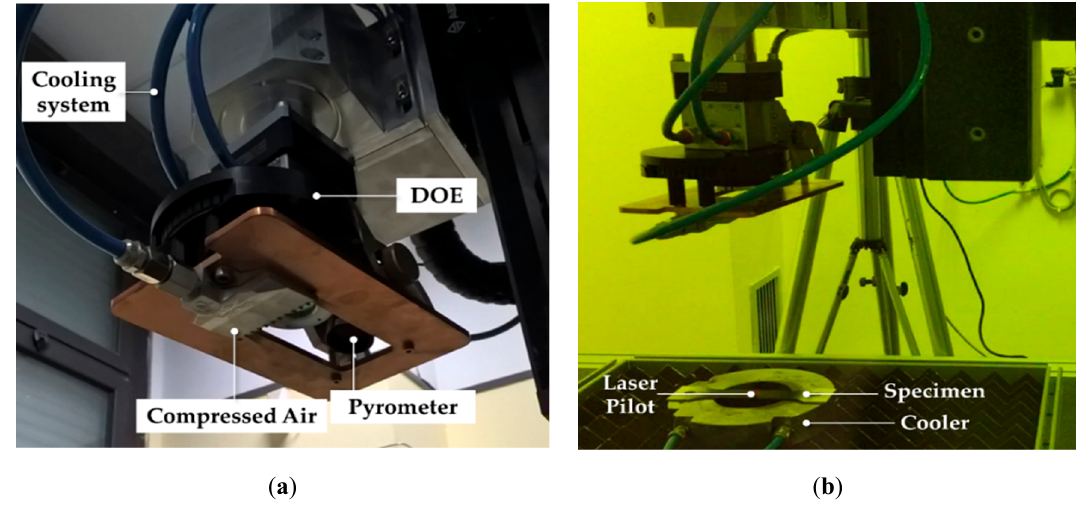
Figure 3. Laser Heat Treatment (LHT) tests on AA6082-T6 tensile specimens: ( a ) detailed view of the laser heating head, ( b ) experimental setup.